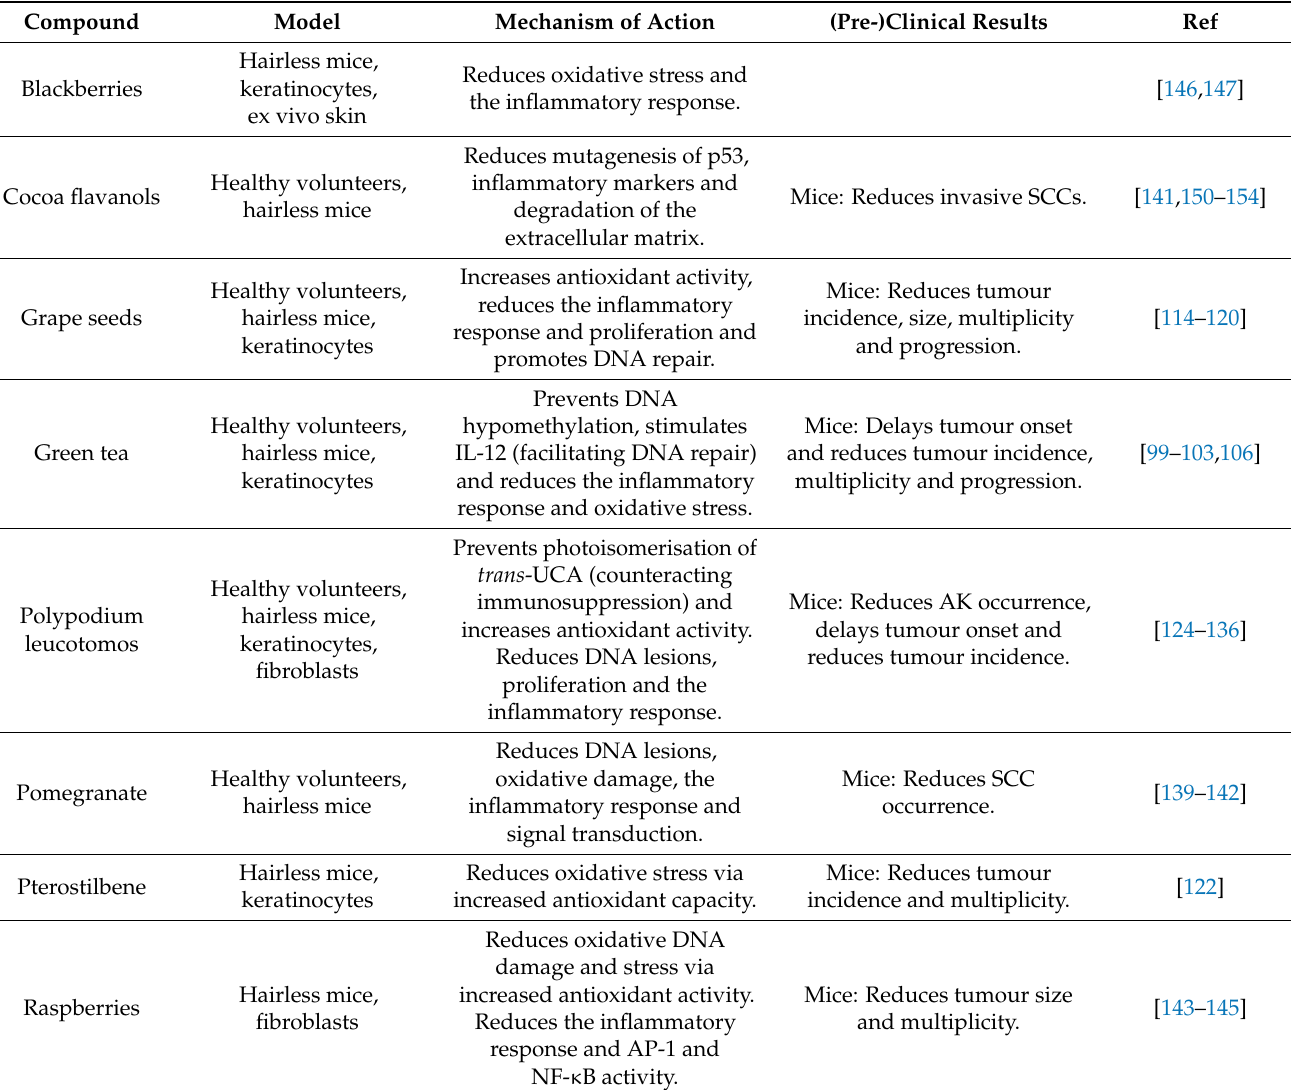
Table 3. Selected phytochemicals that have been tested for photoprotective effects, their proposed mechanisms and, if applicable, (pre-)clinical